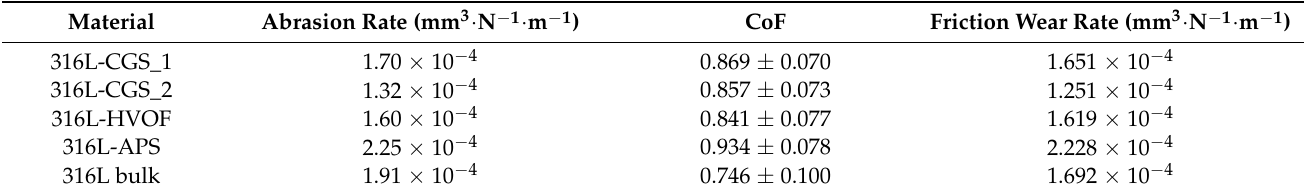
Table 6. Results of ball-on-disk testing for 316L coatings and bulk.